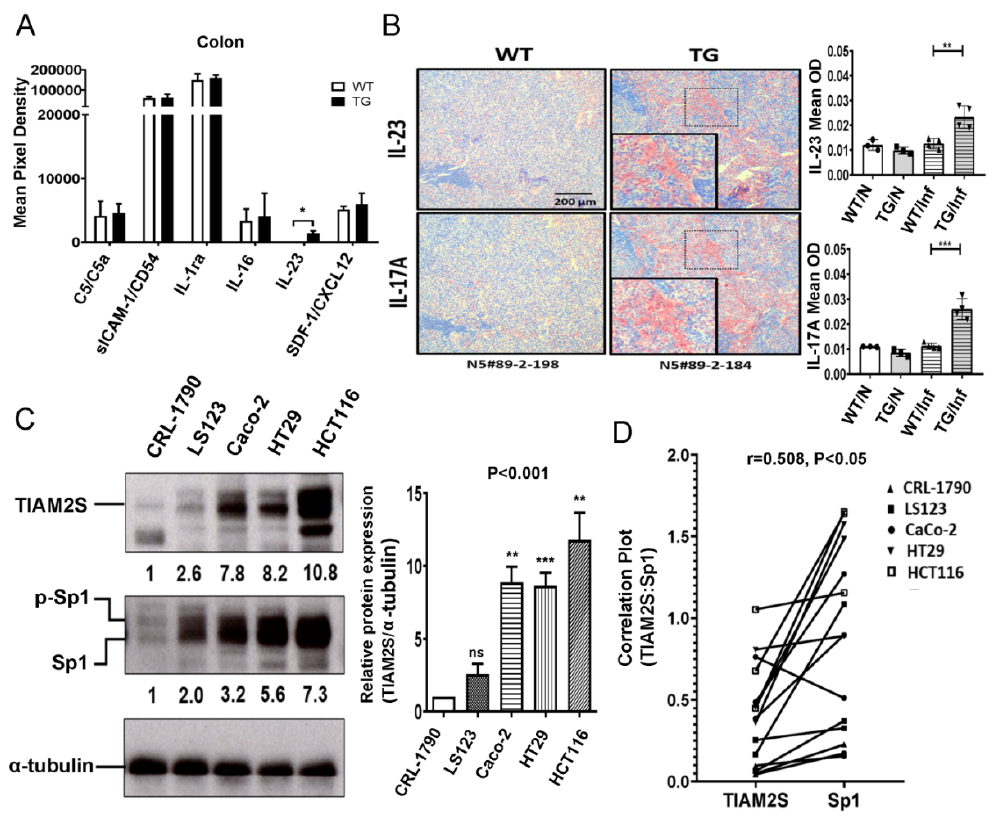
Figure 4. TIAM2S enhances chronic colonic inflammation as a human IBD model. ( A ) Inflammatory cytokine and chemokine profiles of the colon from WT and TIAM2S-TG mice were examined and compared using cytokine and chemokine array. The level of IL-23 was increased in TG groups ( p = 0.0305 by Student’s t -test). ( B ) Representative images of colonic Tertiary Lymphoid Organs (TLOs) were IHC stained with anti-IL23 (upper panel) and -IL-17A (lower panel) antibodies from WT and TG mice with di ff erent inflammatory states (number indicates mice ID). Expression levels of IL-23 and IL-17A were increased in the inflammatory TG mice (IL-23, p < 0.01; IL-17A, p < 0.001 by one-way ANOVA with Bonferroni’s multiple comparison test). ( C ). Representative Western blot image shows the expression of TIAM2S and SP1 in various colon cancer cell lines (Left). The level of α -tubulin was used as loading control. Quantification of TIAM2S and SP1 signal intensities show significantly increased in colorectal carcinoma (CRC) cell lines in comparison with the normal CRL1790 cells (right). ( D ). Pearson correlation analysis shows significant association of TIAM2S and SP1 expressions in various CRC cell lines. For all statistics, NS: not significant, * p < 0.05, ** p < 0.01, *** p < 0.001.